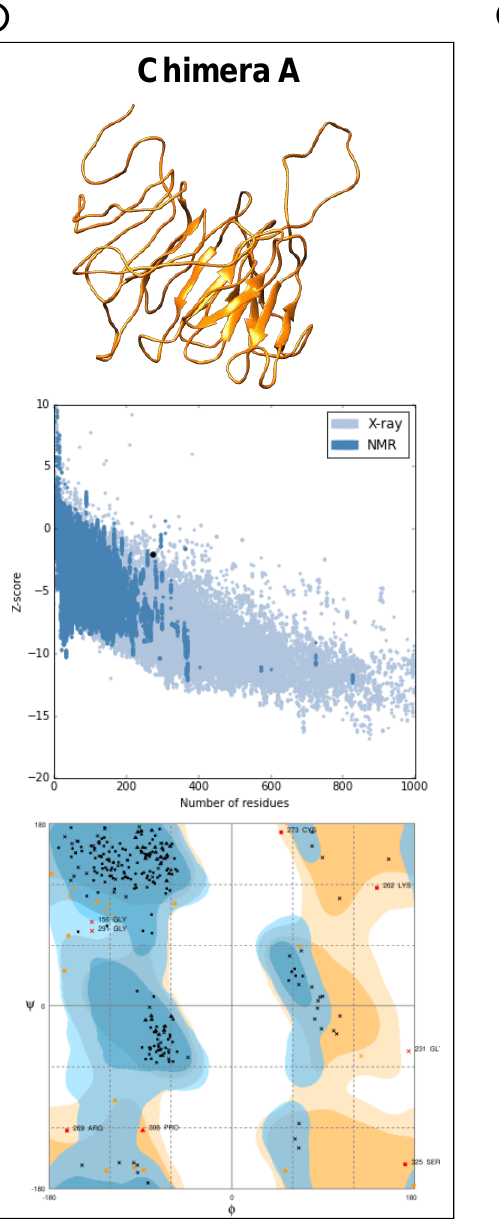
Figure 1. Illustrative representation of 3D structures for chimeras A and B and the validation parameters provided by Rampage and ProSA web servers. Chimera A ( a ) is represented by orange color and chimera B ( b ) is represented by green color. ProSA analysis and Ramachandran diagrams are represented in the figure for both chimeras (above 3D structures). The quality of the models is given by the z-score ( − 3.05) predicted by the ProSA, whereas Ramachandran diagrams show the distribution of the amino acid in favored, allowed, and disallowed